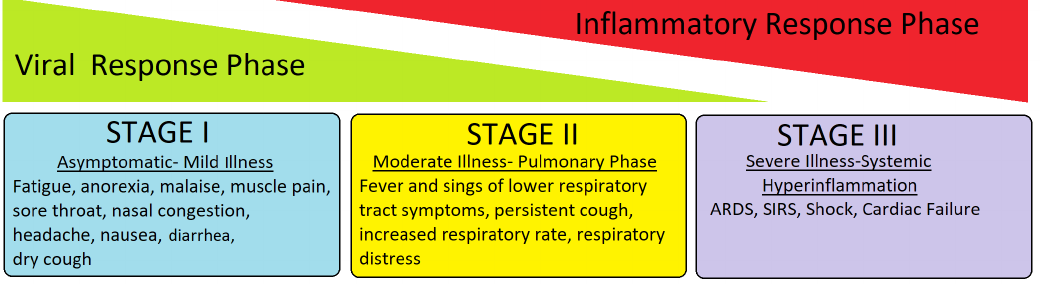
Fig. 1. Proposal for Stages of Covid-19, a 3-stage classification system to establish a standardized nomenclature, facilitate therapeutic application, and evaluate the response and clinical